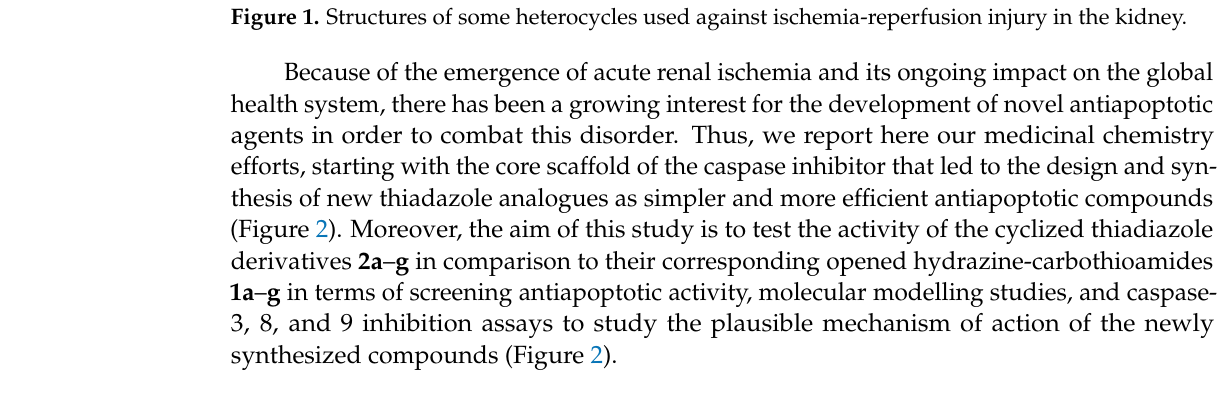
Figure 1. Structures of some heterocycles used against ischemia − reperfusion injury in the kidney.